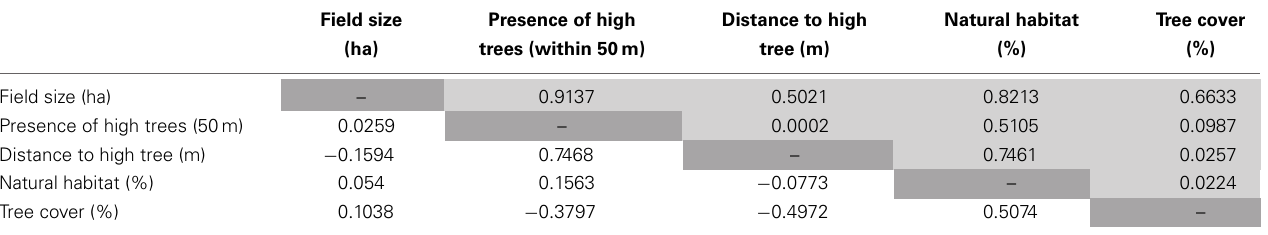
Table 1 | Correlation matrix of the explanatory variables field size in ha, presence of high trees (higher than 5m) within 50m to the sampling points (at least a single tree or a group of trees was present within 50m to the sampling point), distance to the closest high tree (single or group) in m from the sampling point, natural habitat in % surrounding the sampling point in a 1km radius and tree cover in % surrounding the sampling point in a 1km radius) was used to analyze correlations between explanatory variables.